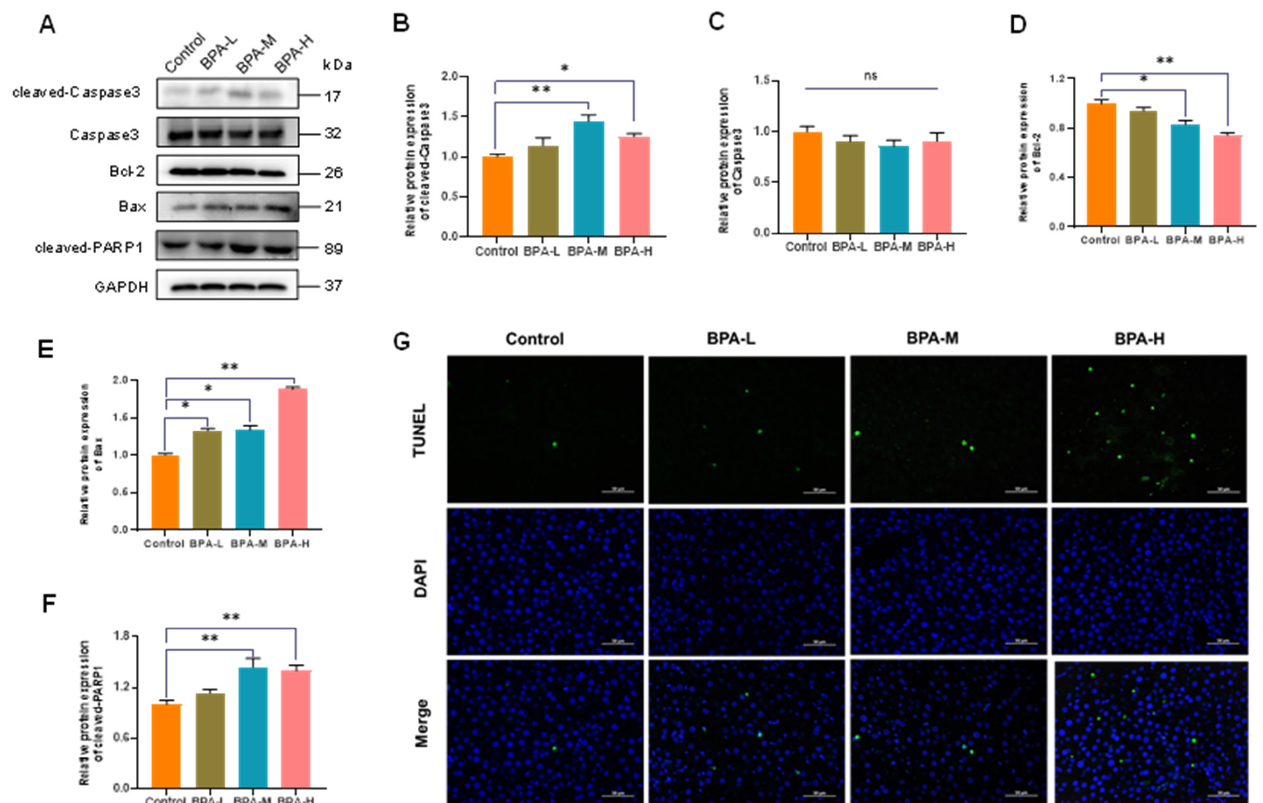
Figure 4. Effects of BPA on apoptosis in the liver from mice treated for 30 days. ( A ) Western blot analysis of apoptosis-related protein levels, and ( B – F ) grey-scale of quantitative analysis. Values are mean ± SEM ( n = 4). * p < 0.05, ** p < 0.01, compared to the Control group. ns: no significance. ( G ) Representative TUNEL images of liver tissues.